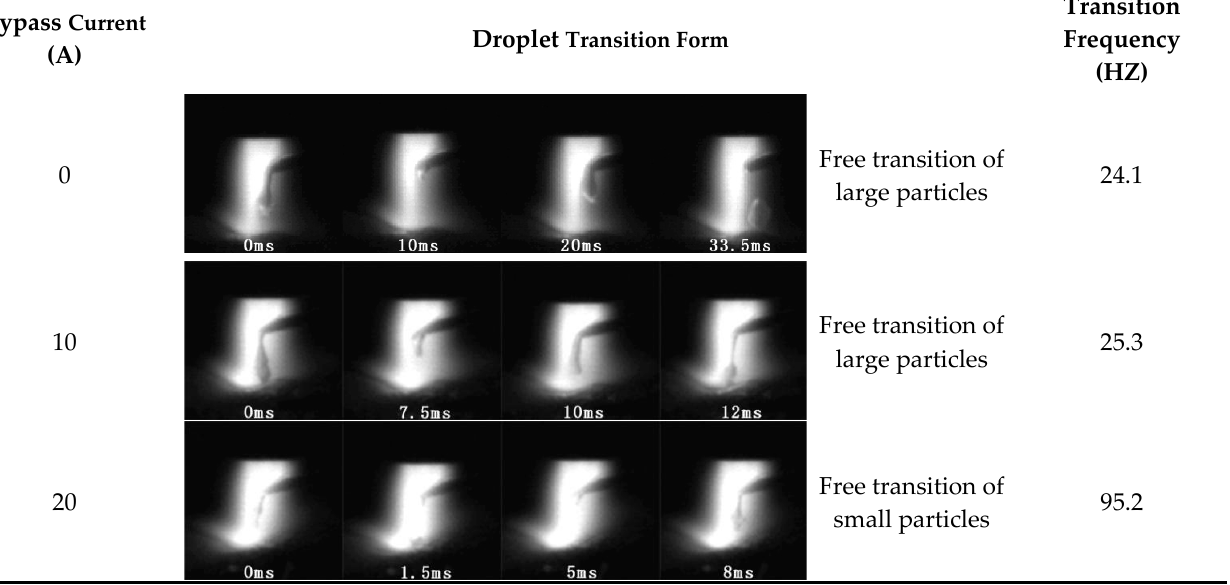
Figure 6. Droplet transfer with the condition of different small bypass current.